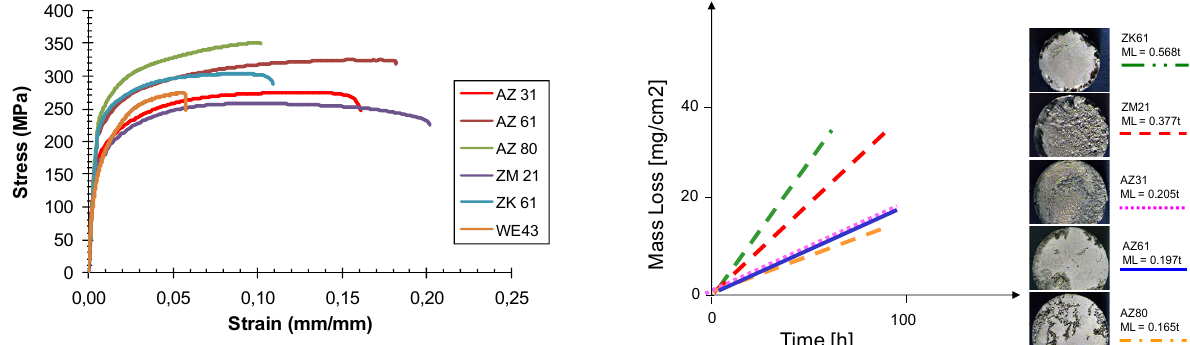
Figure 2: On the left: Tensile curves of the selected magnesium alloys. On the right: mass loss (ML) versus time curves of the studied alloys obtained from immersion tests and corresponding ML values and optical images of the specimens observed after 90h.